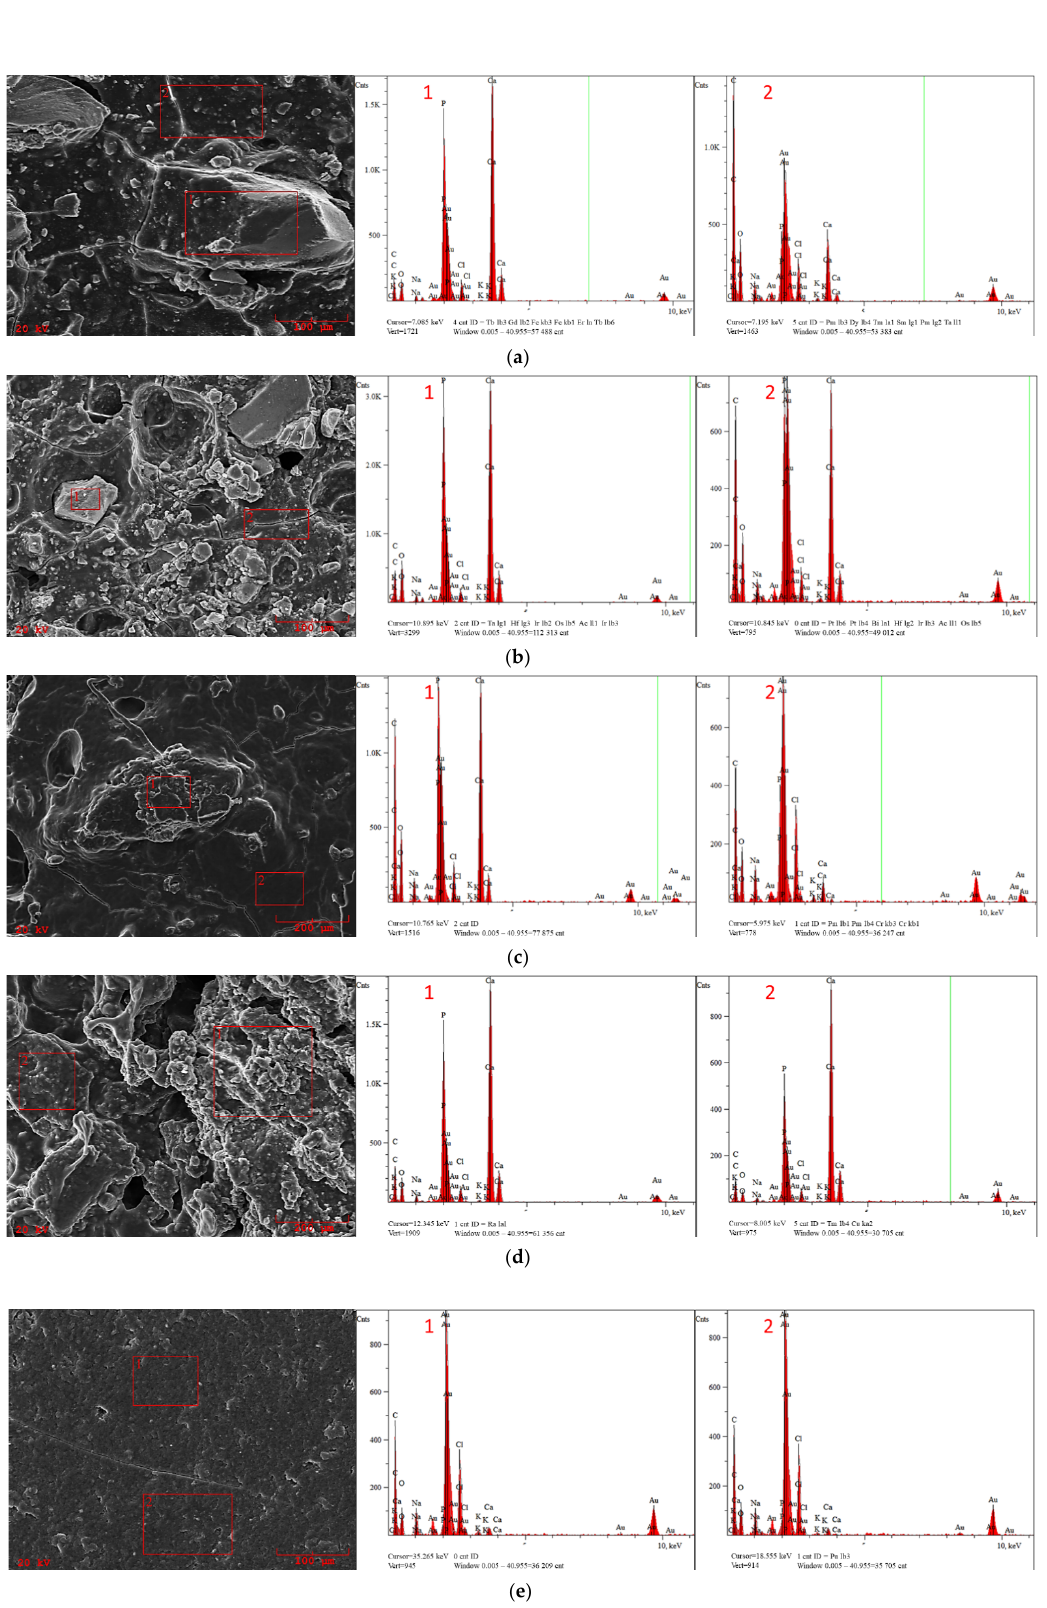
Figure 7. SEM morphology and EDS microanalysis of the composites and the pure WPI matrix after incubation in SBF: ( a ) WPI A5; ( b ) WPI A15; ( c ) WPI B5; ( d ) WPI D15; ( e ) pure WPI hydrogel.